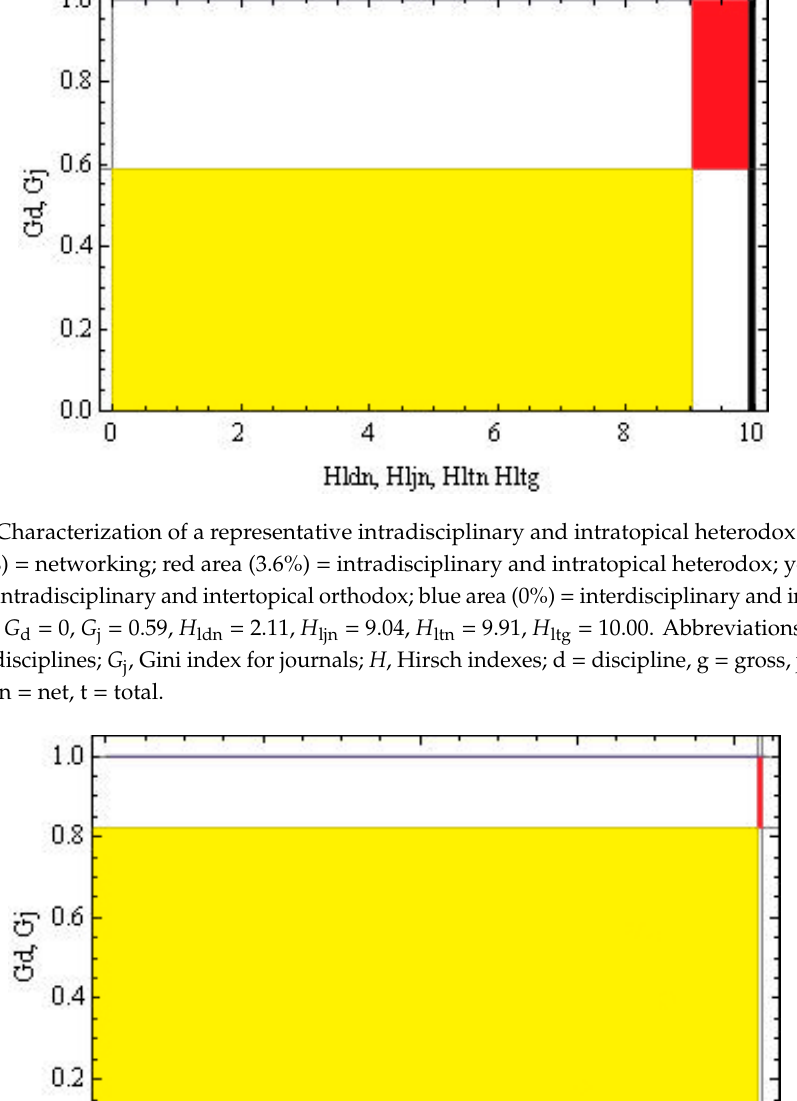
Figure 5. Characterization of a representative interdisciplinary and intertopical orthodox PH. Black area (14.3%) = networking; red area (0.3%) = intradisciplinary and intratopical heterodox; yellow area (4.1%) = intradisciplinary and intertopical orthodox; blue area (53.9%) = interdisciplinary and intertopical orthodox. G d = 0.72, G j = 0.97, H ldn = 4.71, H ljn = 5.74, H ltn = 6.29, H ltg = 7.34. Abbreviations: G d , Gini index for disciplines; G j , Gini index for journals; H , Hirsch indexes; d = discipline, g = gross, j = journal, l = linear, n = net, t = total.